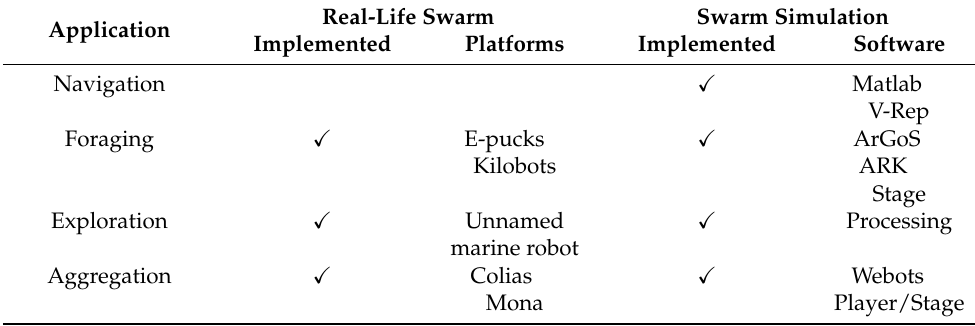
Table 4. Swarm robotics